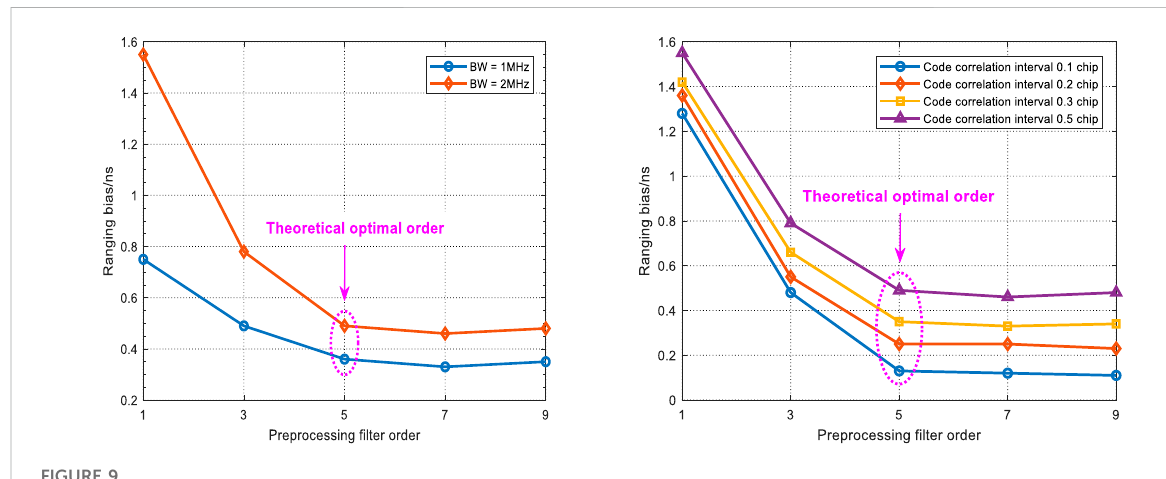
FIGURE 9 Optimal order under different interference scenarios and correlator